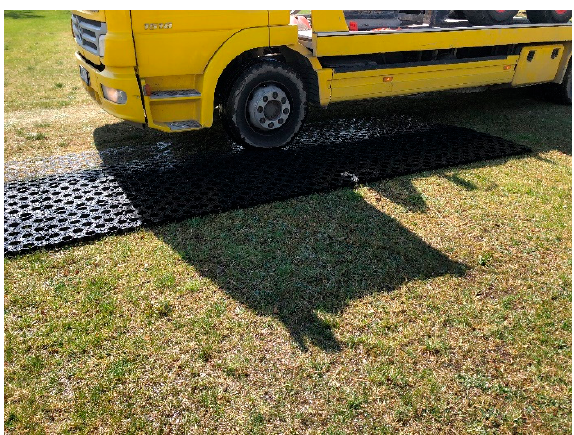
Figure 19. The process of pressing the airfield geocell into the natural airfield pavement.